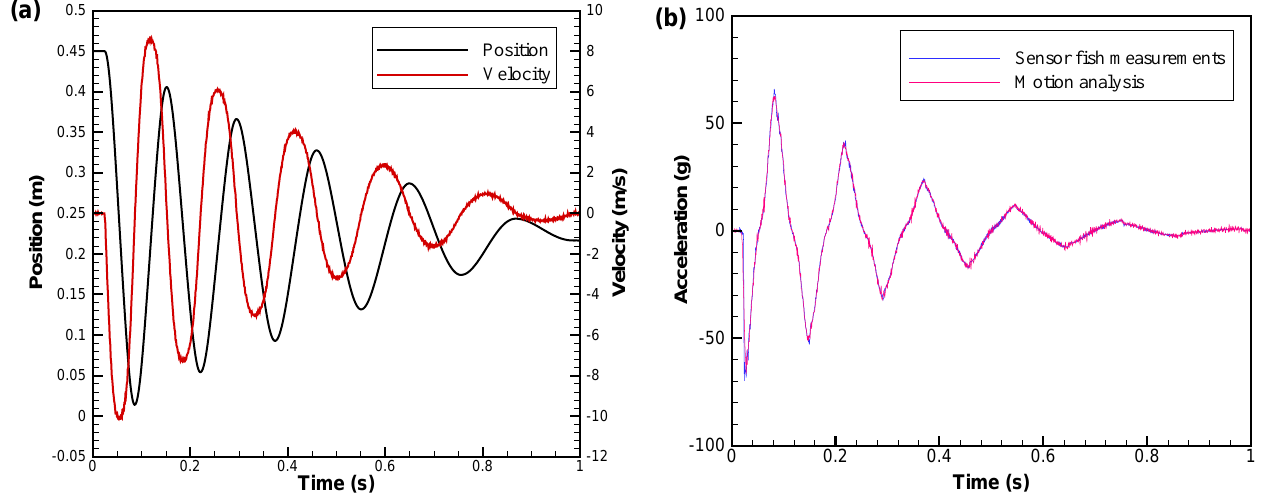
Figure 5 . An example of calibration of linear acceleration in x-direction by comparing the Sensor Fish measurements and motion analysis results, using the unforced spring-mass-damper system.